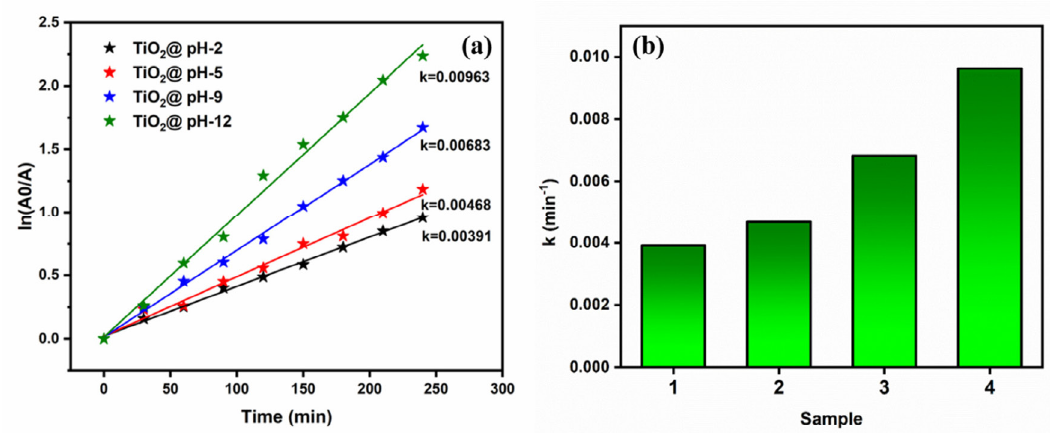
Fig. 10. (a) Pseudo-first-order kinetics plot (b) the kinetic rate constant for all the four samples.